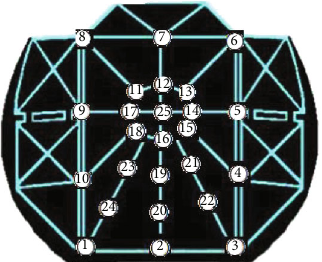
Figure 3: Middle plate of the deployable antenna